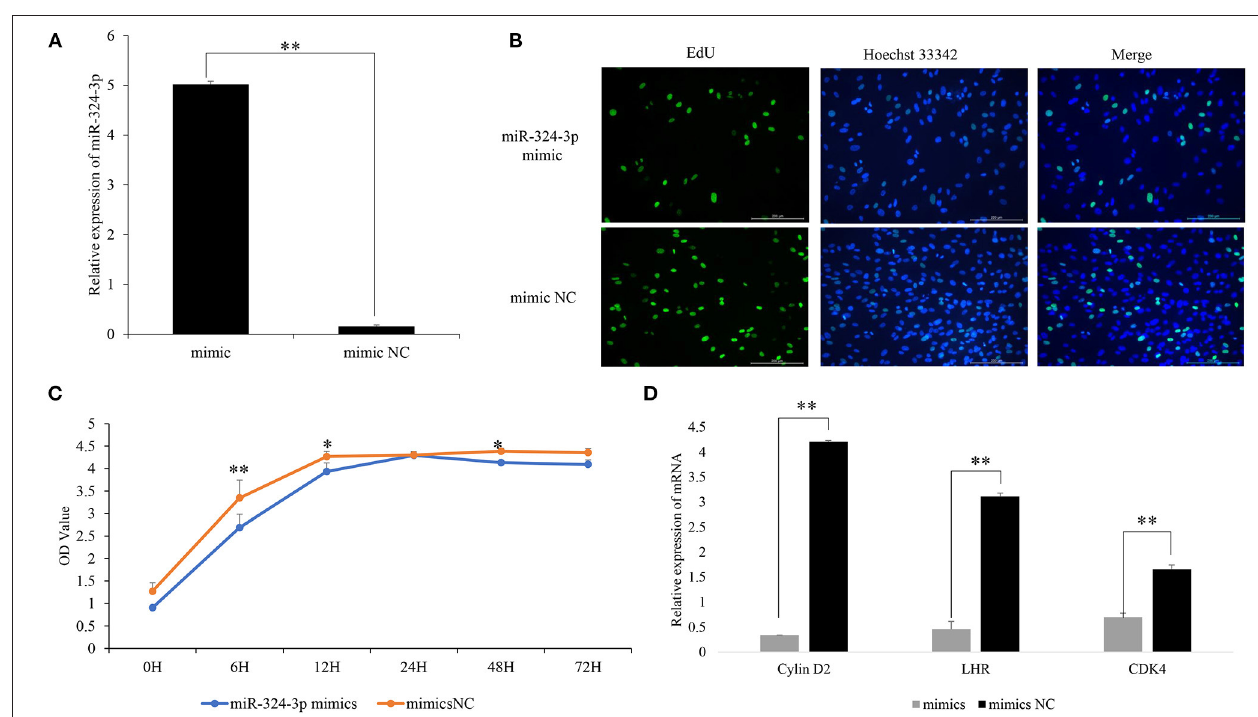
FIGURE 2 | Overexpression of chi-miR-324-3p in goat GCs. (A) Relative expression of miR-324-3p. (B) The result of EdU assay. (C) CCK-8 assay of goat GCs with miR-324-3p mimic and mimic NC transfection at 0–72h. (D) Relative expressions of LHR , CDK4 , and Cylin D2 in transfected chi-miR-324-3p mimic and mimic NC at 48h. * p < 0.05; ** p < 0.01. CCK-8, Cell Counting Kit-8; GC, granulosa